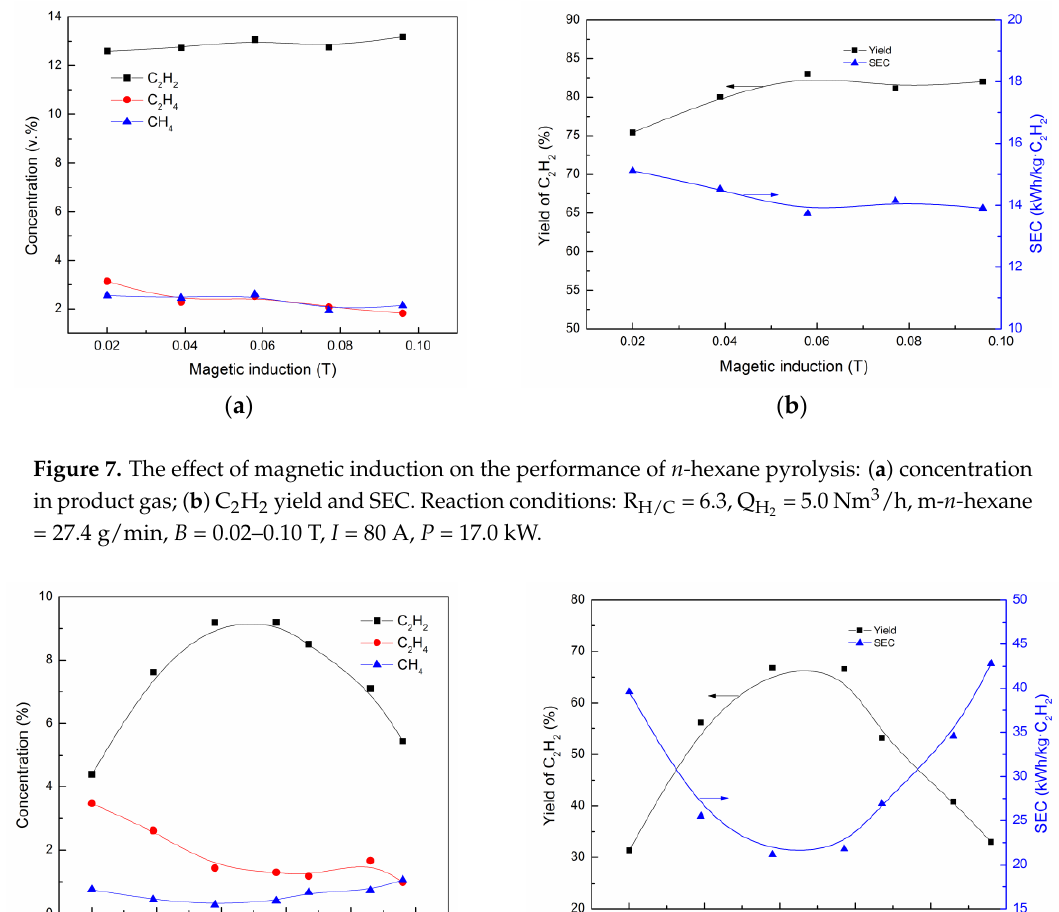
Q = 5.0 Nm 3 /h, m-toluene = 18.8 g/min, B = 0.02– H 2